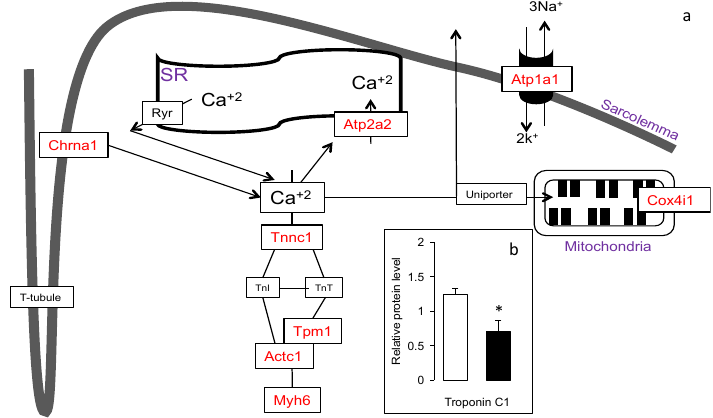
Figure 2. Pathway analysis of the gSkM transcriptome for the comparison HFD-ED versus HFD-corn oil fed mice. The illustration is based on the Kegg pathway database (http://www.genome.jp/kegg/ pathway.html). ( a ) Nerve-Muscle contraction: Genes highlighted in red are upregulated in gSkM of mice fed HFD-ED compared with HFD-corn oil; ( b ) Relative Troponin C1 protein level in HFD-corn oil (black bars) fed mice was lower than HFD-ED (white bars). * Different at p <